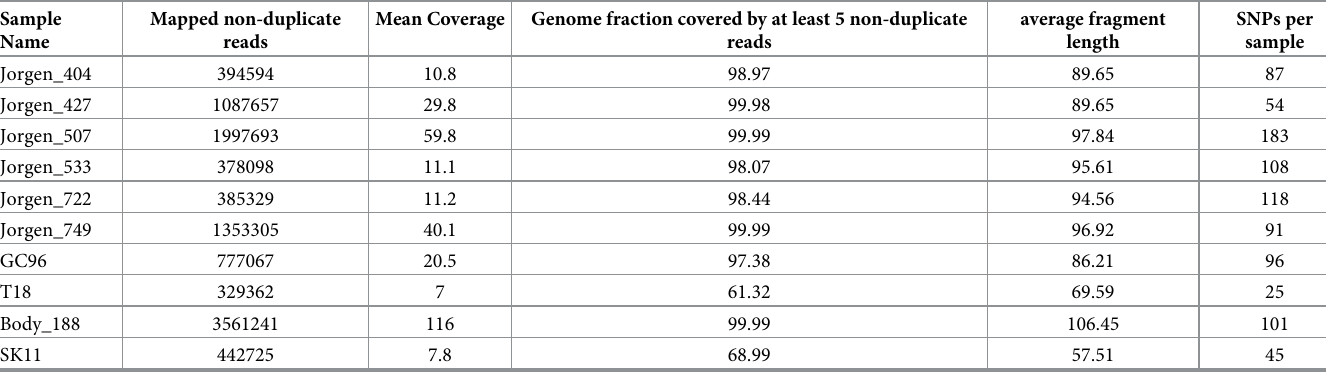
Table 1. Results of the genome-wide analysis for the samples with sufficient coverage. Sample